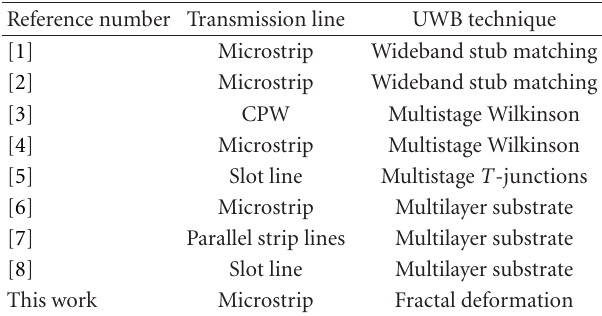
Table 1: Topology and widebanding techniques comparison between 3 dB couplers and power dividers.